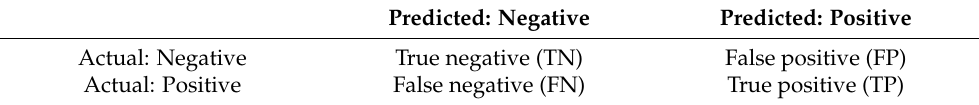
Table 2. Confusion